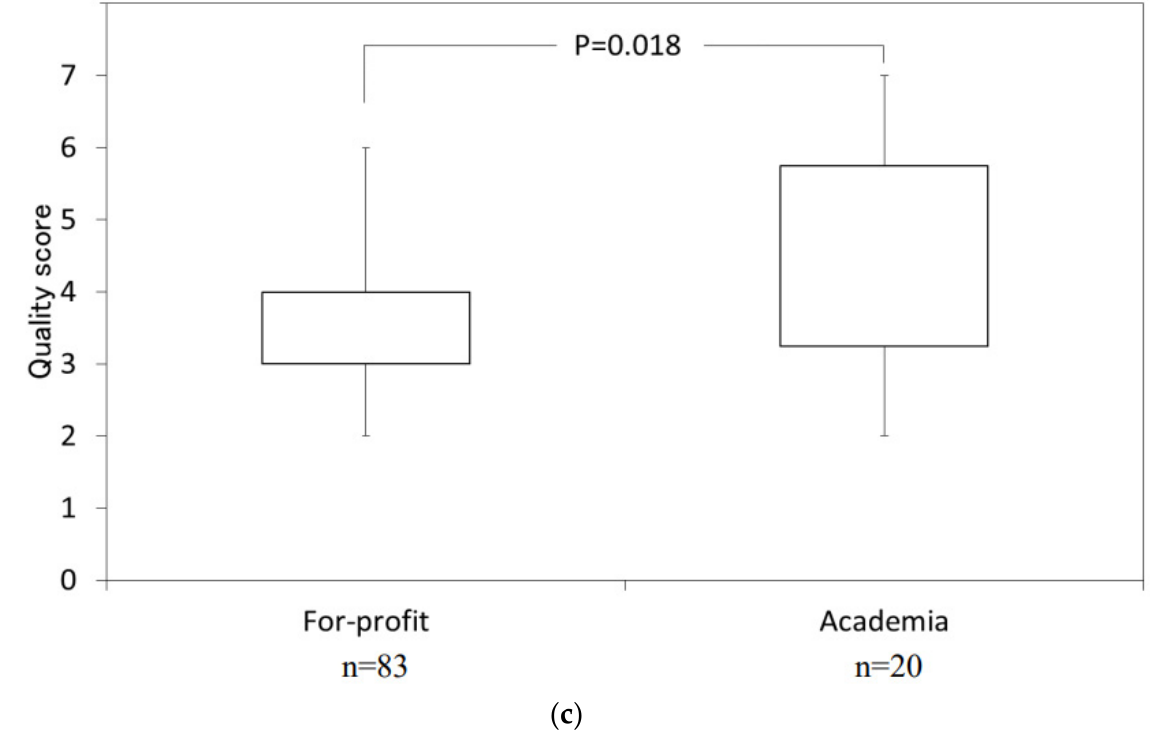
Figure 4. Correlation between journal’s impact factor and quality score. Spearman’s rank correlation coefficient. p -value less than 0.05 was considered statistically significant.